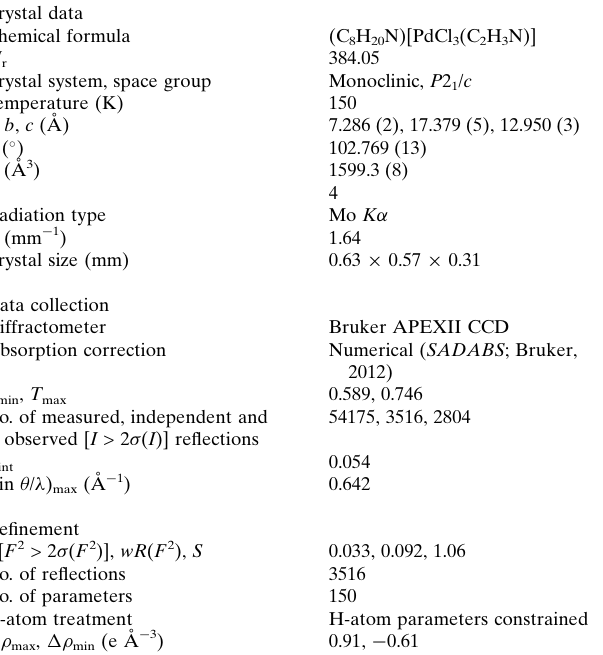
Table 2 Experimental details.